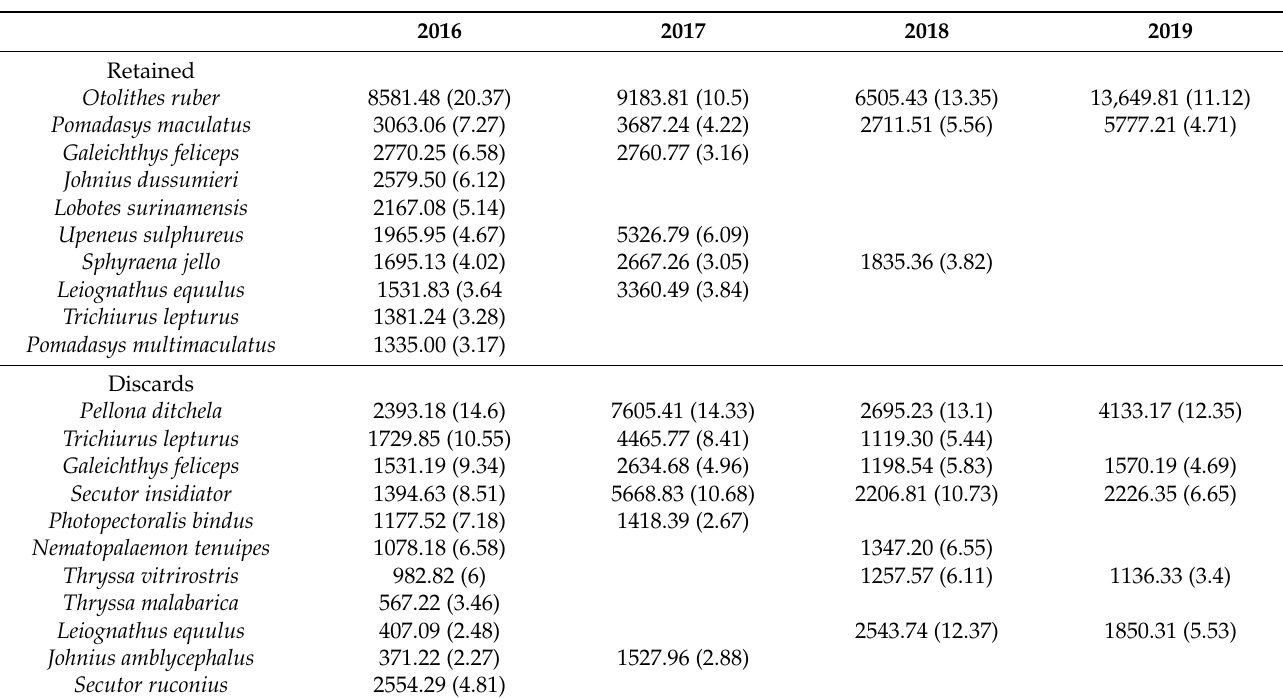
Table 2. Top-ten species by weight of retained and discarded species recorded from 2016 to 2019. Weight in kg (percentage).